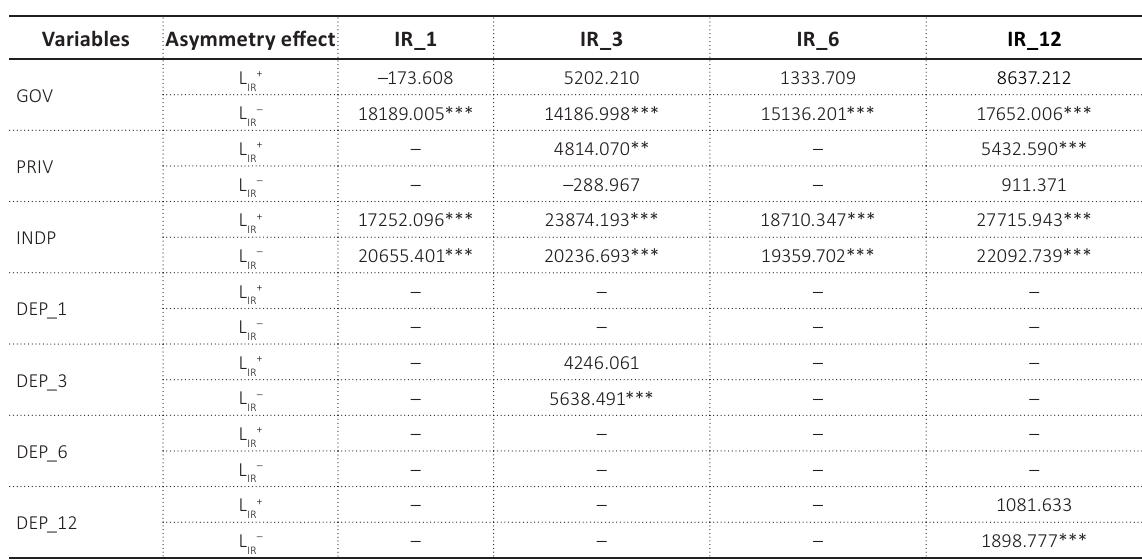
Table 5. NARDL long-run asymmetry